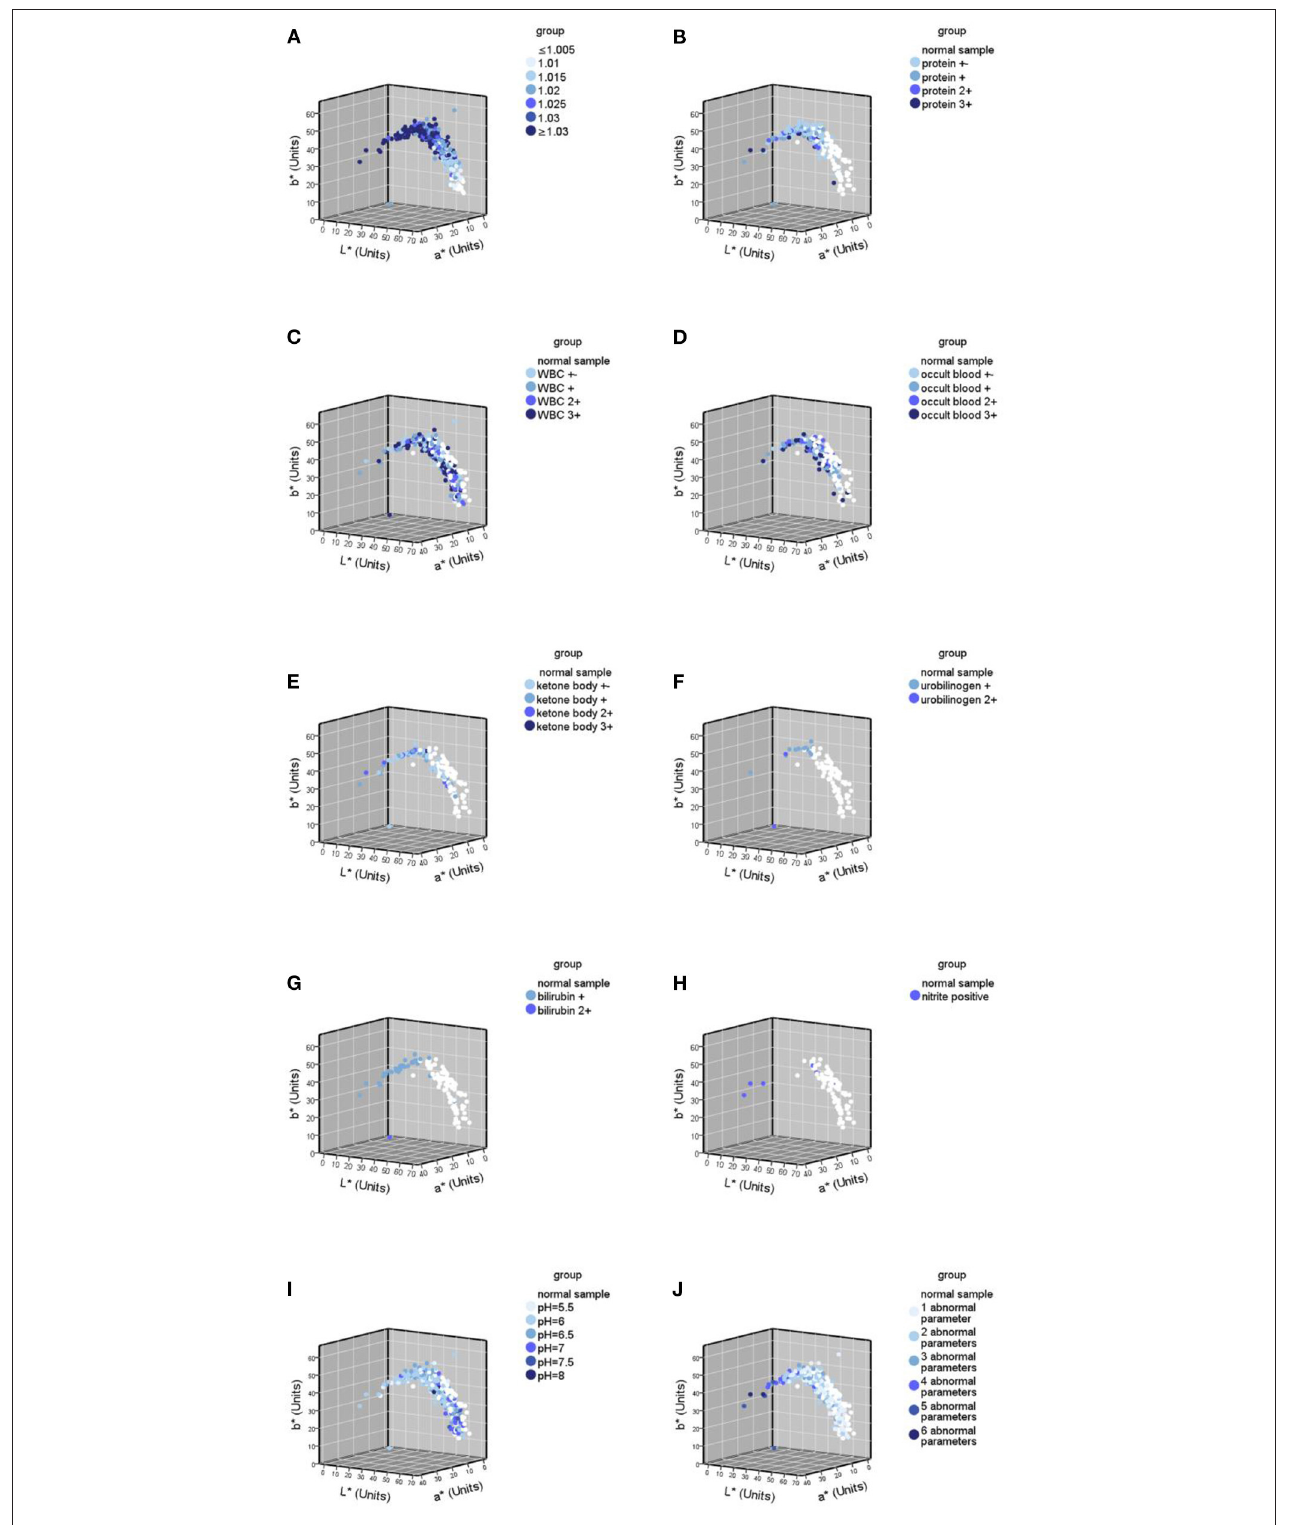
FIGURE 5 | Urine color distribution diagram of various abnormal parameters in urine samples ( n = 524). (A) Urine color distribution diagram classified by urine specific gravity (USG); (B–H) urine color distribution diagram of various parameters; (B) yhe diagram of urine samples containing protein abnormalities; (C) the diagram of urine samples containing white blood cell (WBC) abnormalities; (D) the diagram of urine samples containing occult blood abnormalities; (E) the diagram of urine